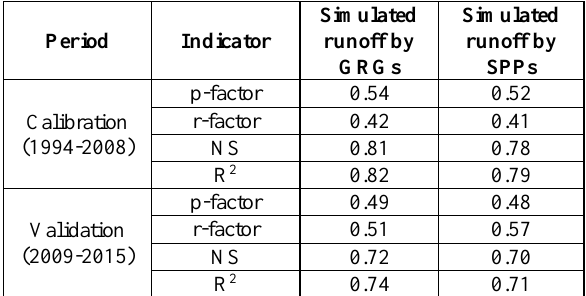
Table 3. Calibration and validation results of the developed SWAT model based on GRGs and SPPs